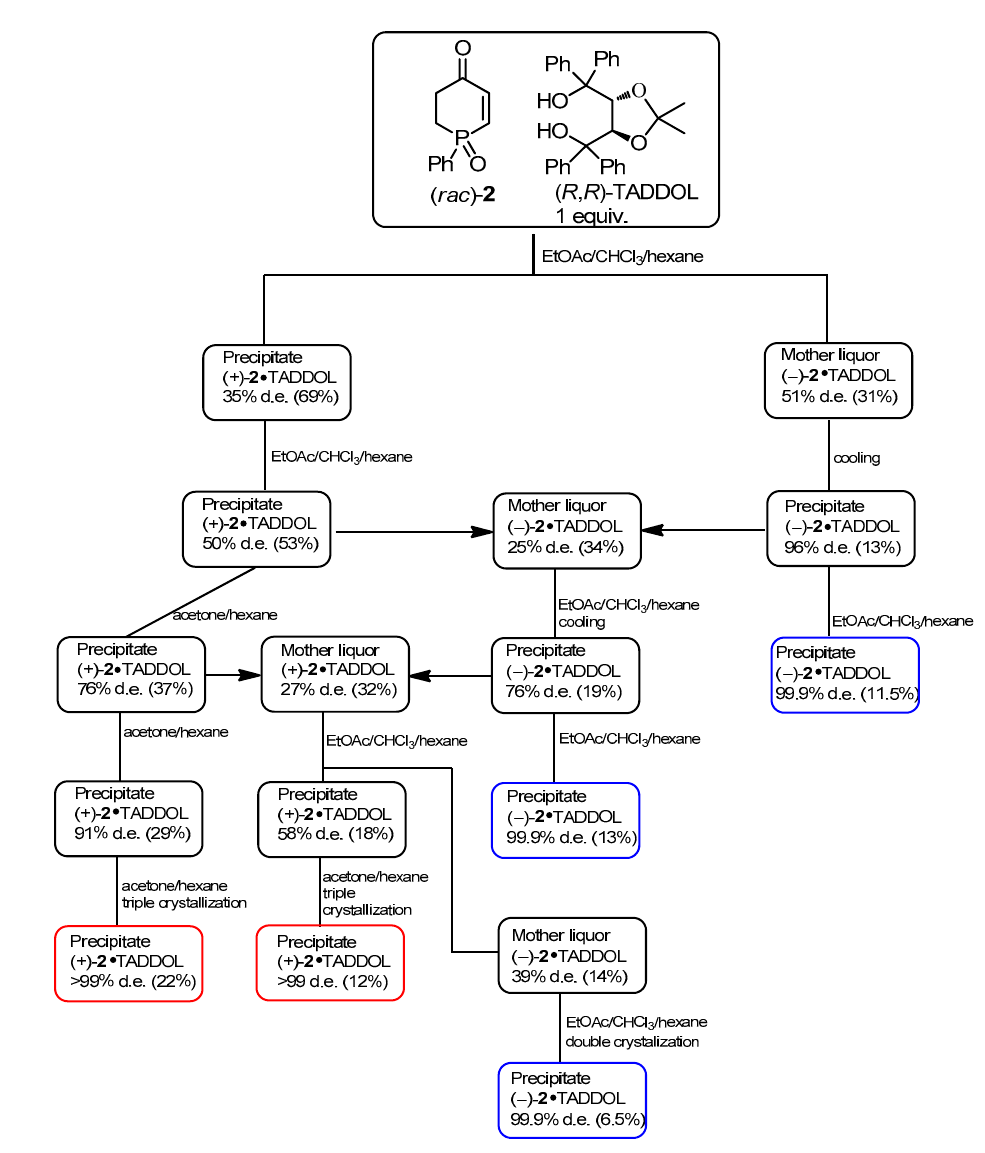
Figure 2. Gram-scale resolution of 1-phenylphosphin-en-4-one 1-oxide ( 2 ) by ( R , R